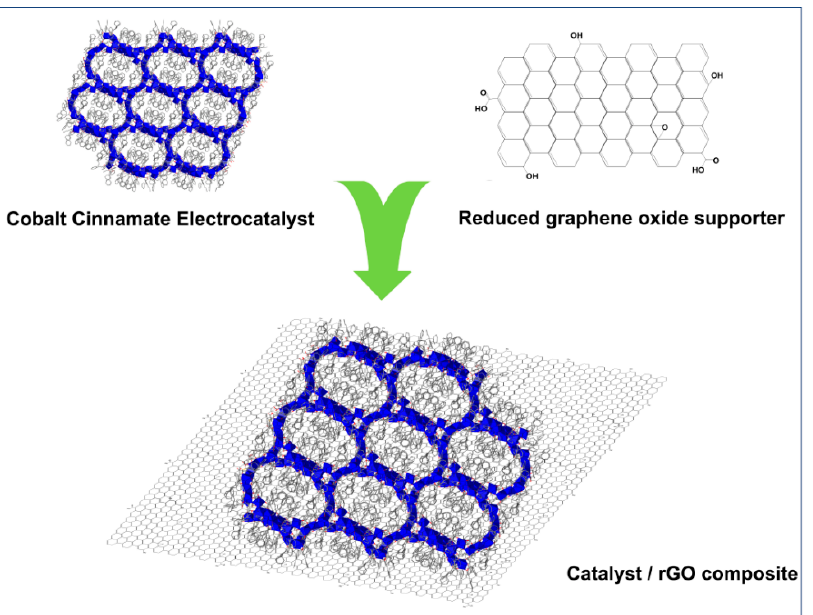
Figure 1. Schematic illustration of the cobalt cinnamate/rGO composite.